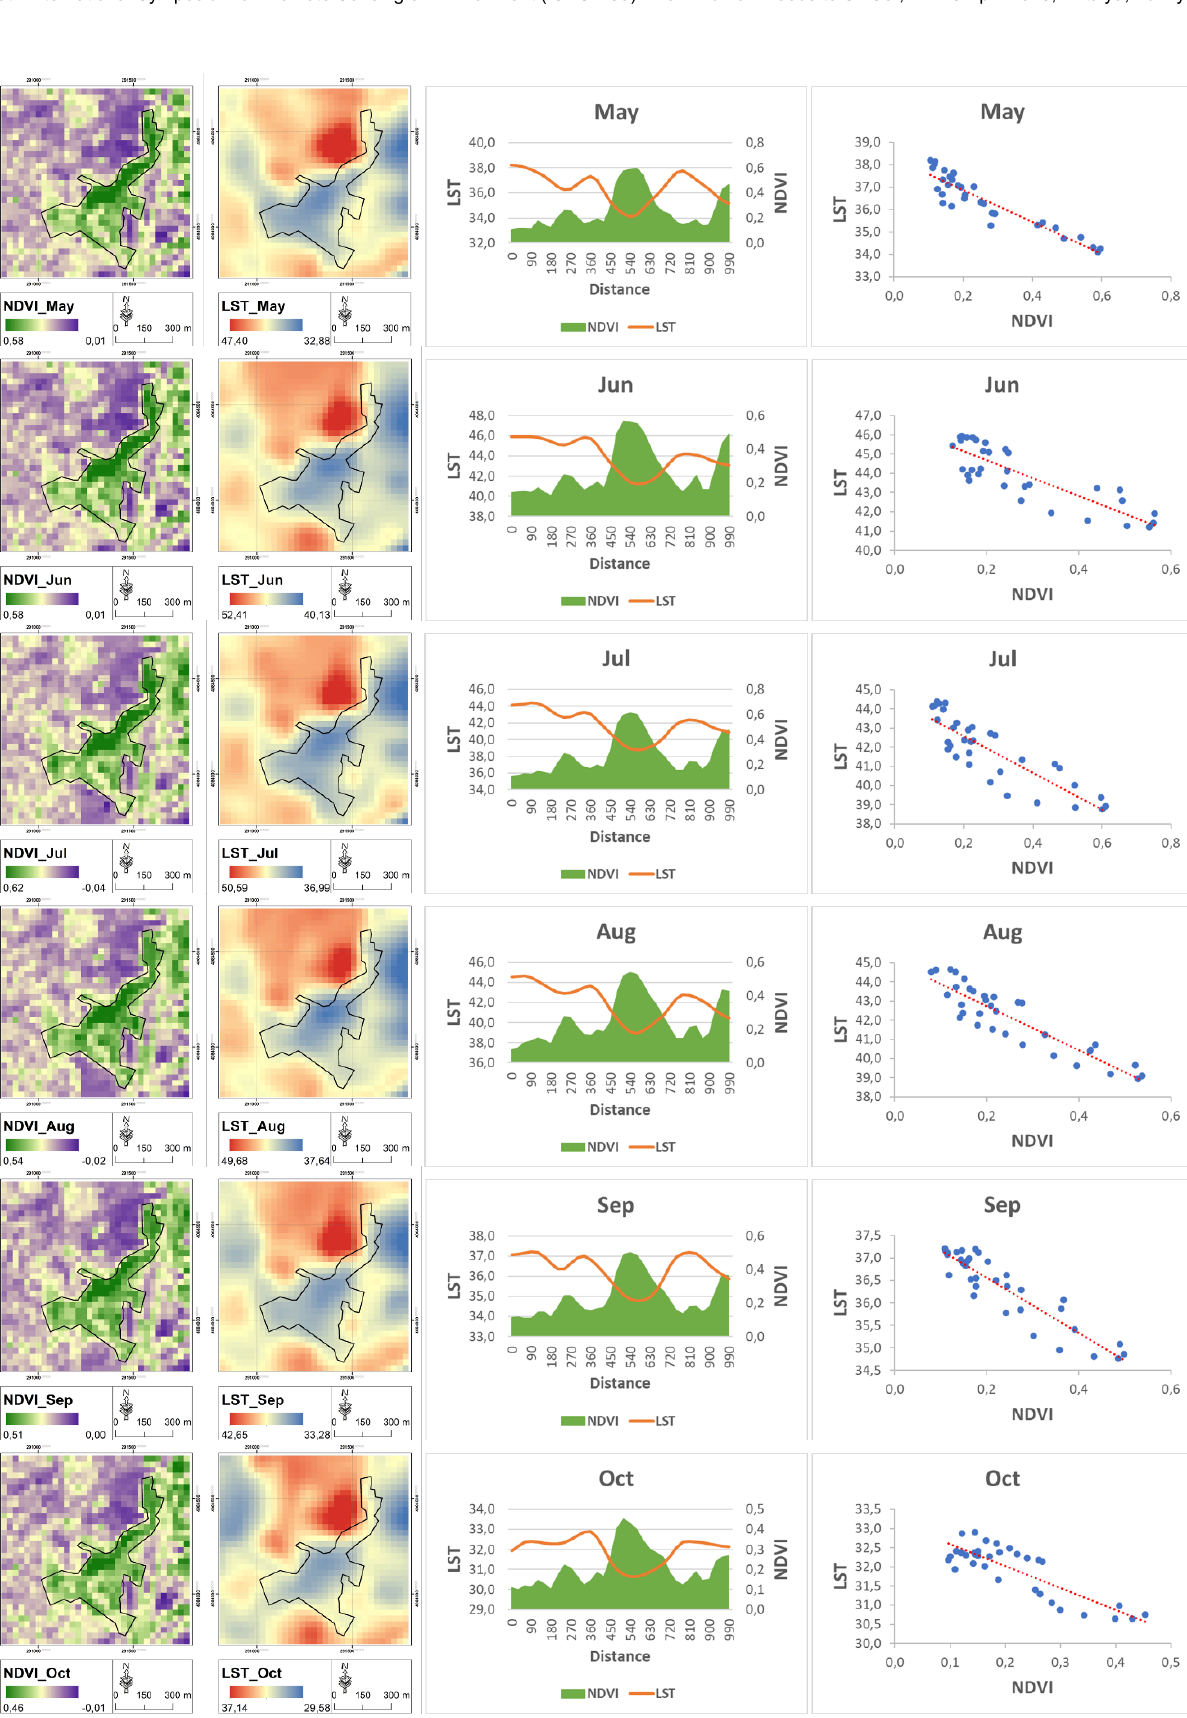
Figure 4 . Monthly maps and graphs of the NDVI and LST for the Akdeniz Kent Park and Fairground sample